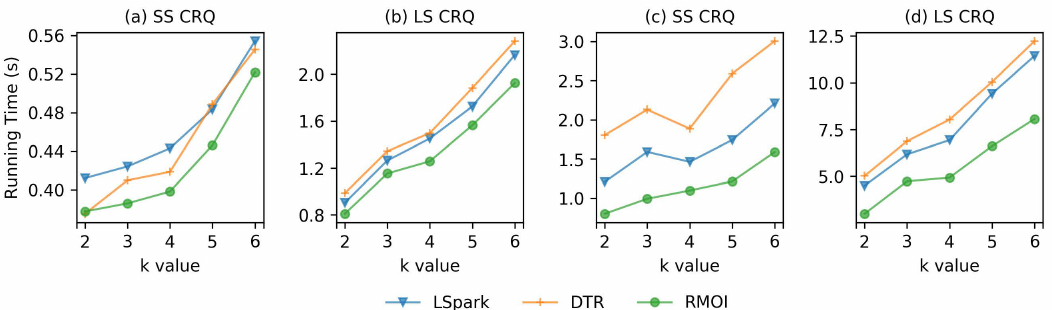
Figure 9. Average execution time of the continuous range query for the UK + IE dataset with ( a ) high resource availability and small selectivity, ( b ) high resource availability and large selectivity, ( c ) low resource availability and small selectivity, and ( d ) low resource availability and large